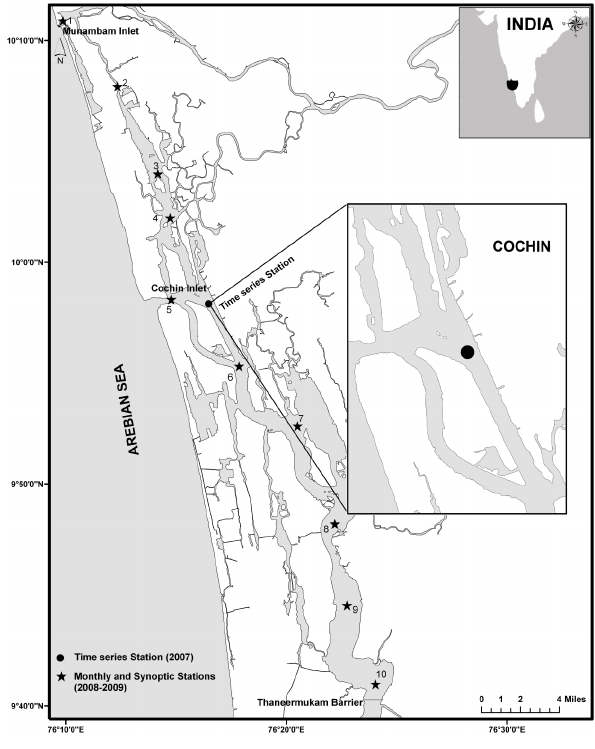
Fig. 1. The Cochin estuary (West coast, India), showing stations and extent of backwaters, having two inlets to Arabian Sea Munambam (north) and Cochin inlet (middle of the extent of backwaters). The time series station which is located 5km way from Cochin inlet. Synoptic and monthly stations are discerningly marked in the back-